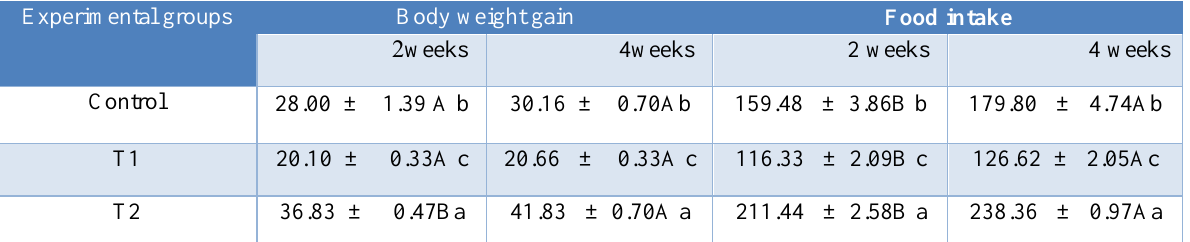
Table, 1: Body weight gain ( g/ animal / two weeks) and Food intake ( g/ animal / two weeks) under effect of biogenic Se- Nanoparticles in compare with selenite solution during 4 weeks, Means ±SE. n- 6. Experimental groups